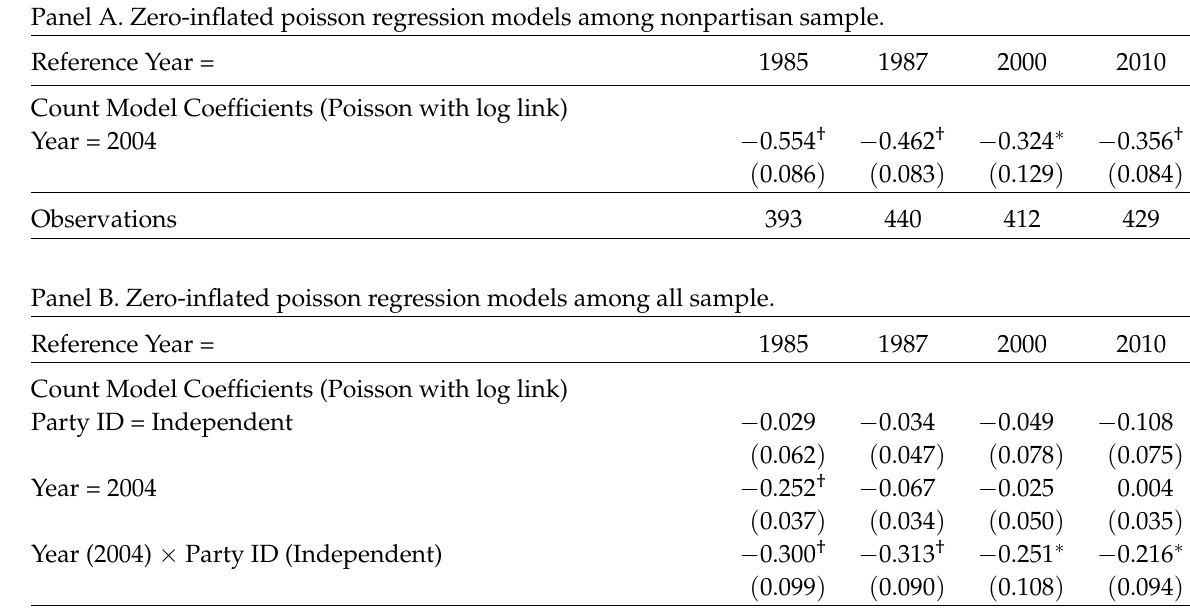
Table 2: The difference in differences of network size between partisans and nonpartisans across time with reference to the 2004 GSS